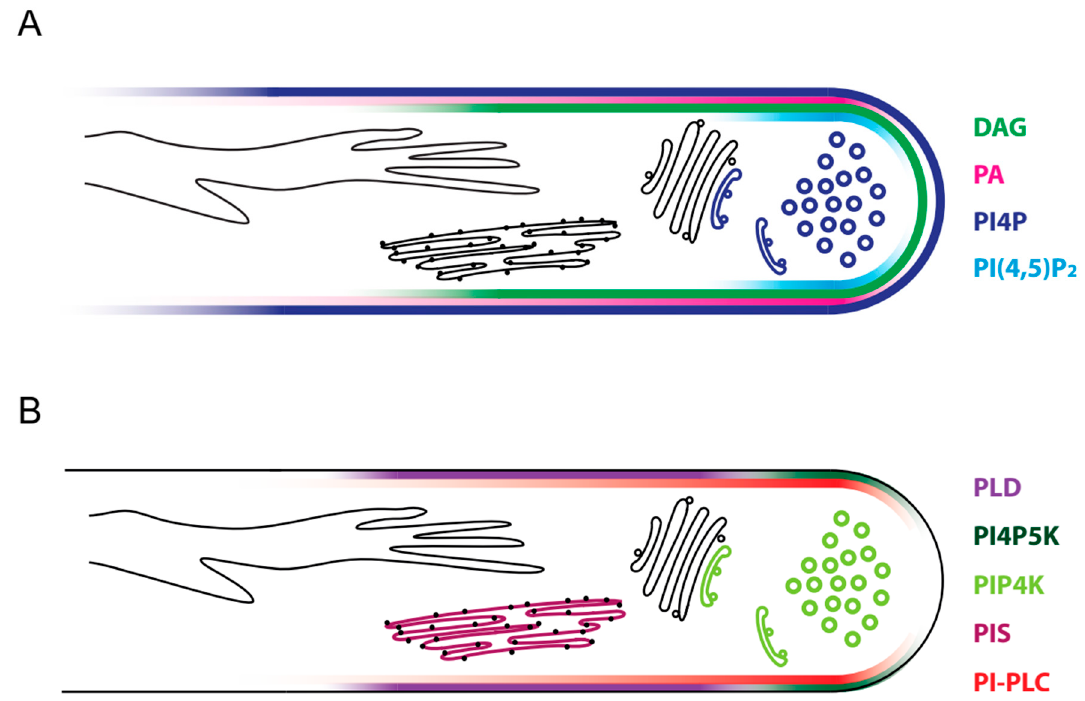
Figure 4. Several signalling lipids and the enzymes involved in their synthesis and degradation are localized at the apical plasma membrane. Several phosphoinositides and derived lipids are involved in pollen tube growth regulation. Their specific localisations in the plasma membrane are positional markers in secretory and endocytic processes and can be detected with the help of fluorescent lipid sensors ( A ). Enzymes acting on lipids of the phosphoinositide network show overlapping localisation to their products ( B ).